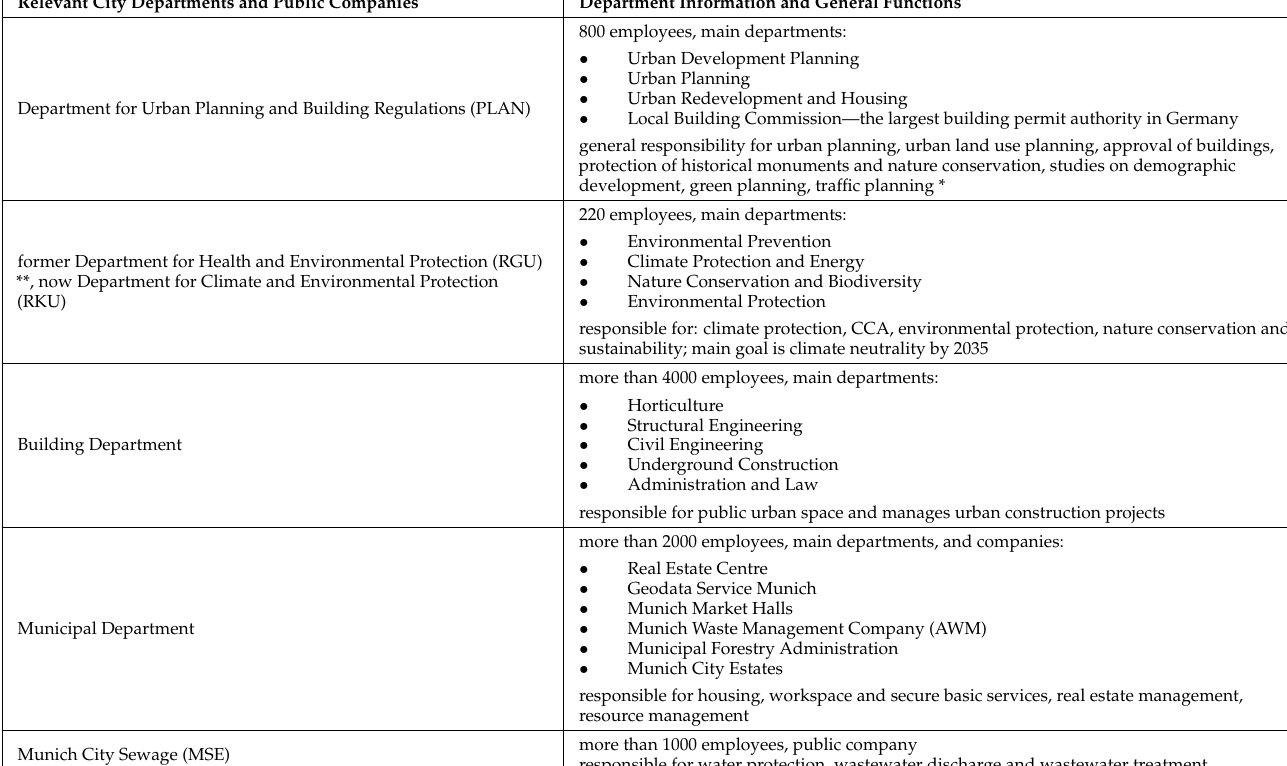
Table A1. General functions and specific responsibilities for CCA for each of the relevant